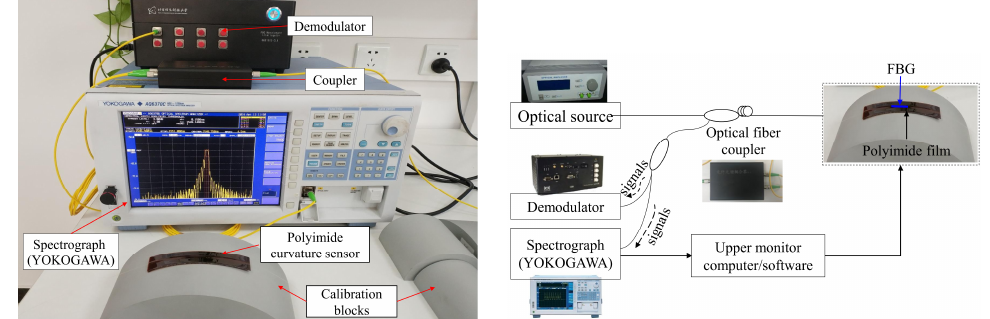
Figure 3. Setup used to study the polyimide film curvature sensor